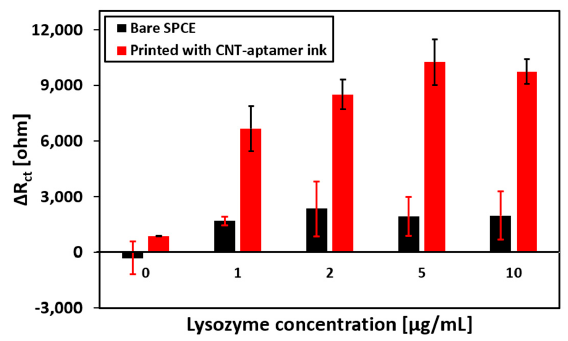
Figure 6. Change of charge transfer resistance (R ct ) due to lysozyme exposure to bare SPCE (black bars) and printed SPCE (red bars) for different lysozyme concentrations.